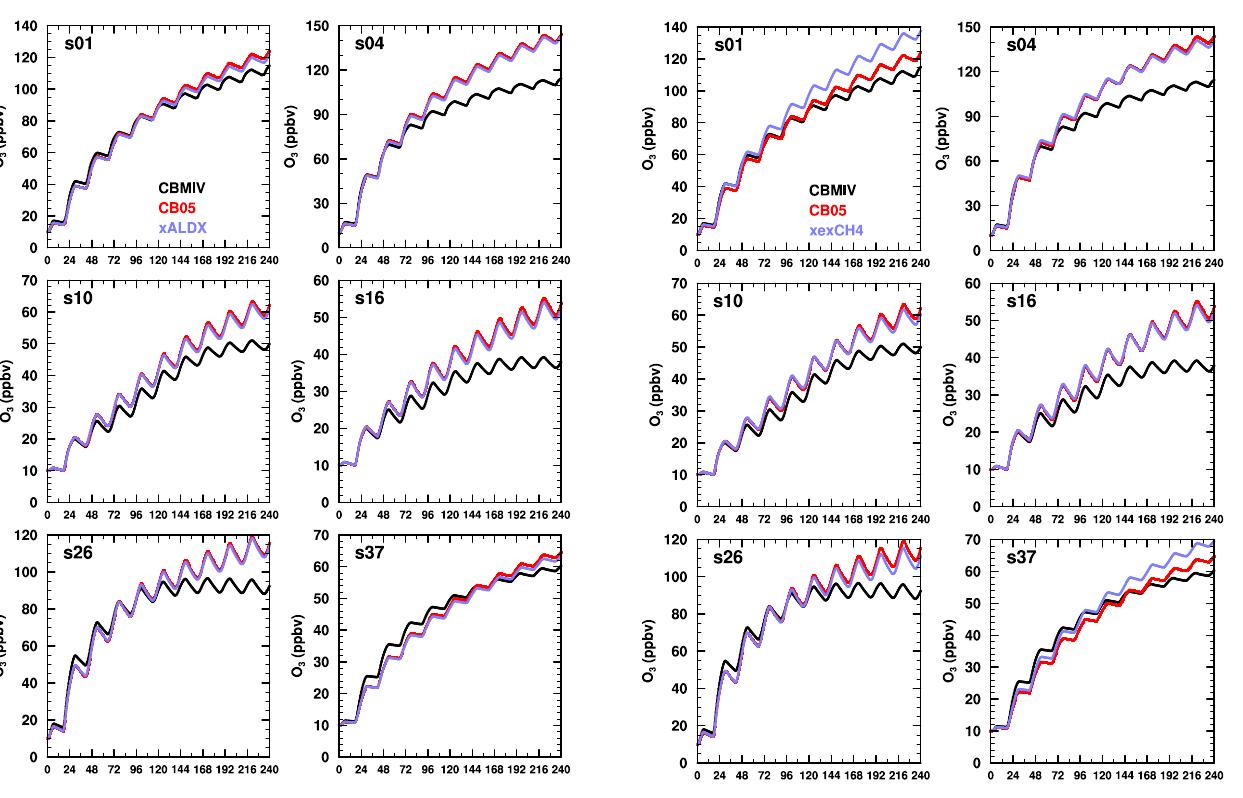
Fig. 3. Example scenario results for sensitivity test xALDX. Ozone Figure 3 . Example scenario results for sensitivity test xALDX . Ozone mixing ratios (ppbv) 5 mixing ratios (ppbv) for the base CB05 (red), base CBMIV (black) for the base CB05 (red), base CBMIV (black) and sensitivity test xALDX (violet) over the 240 6 hr simulation period. 7 and sensitivity test xALDX (violet) over the 240 hr simulation pe- 8 riod.